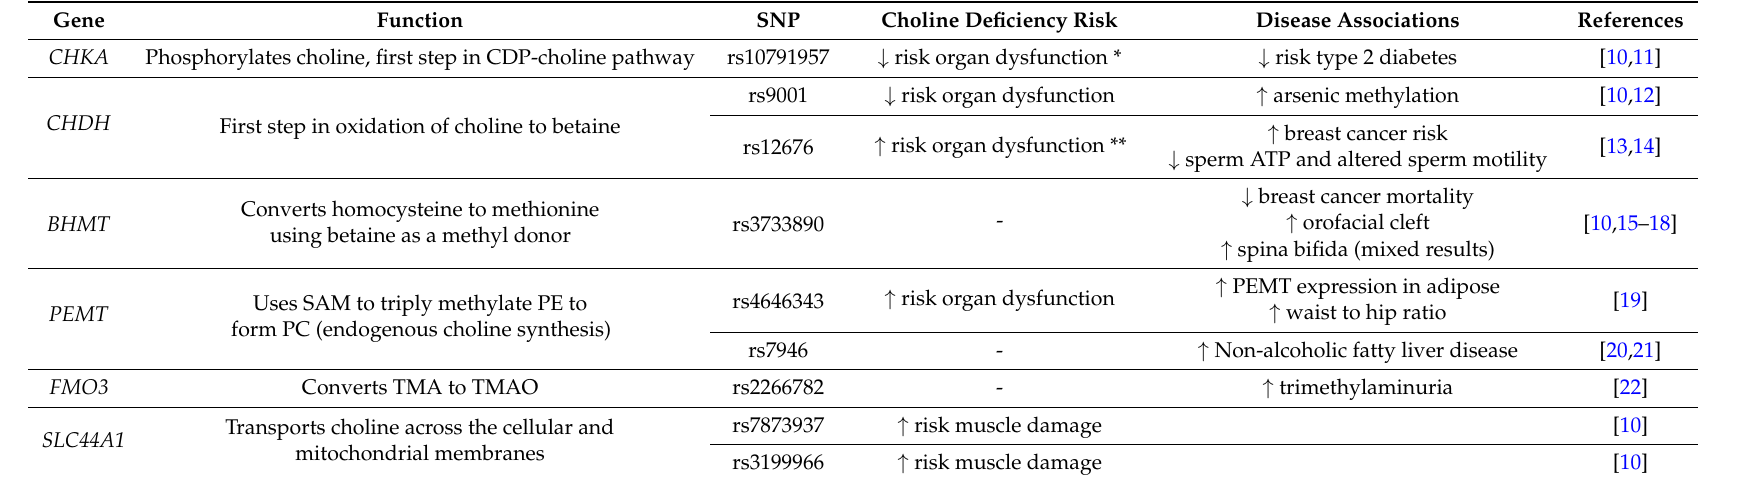
Table 1. Summary of examined SNPs and their connections to